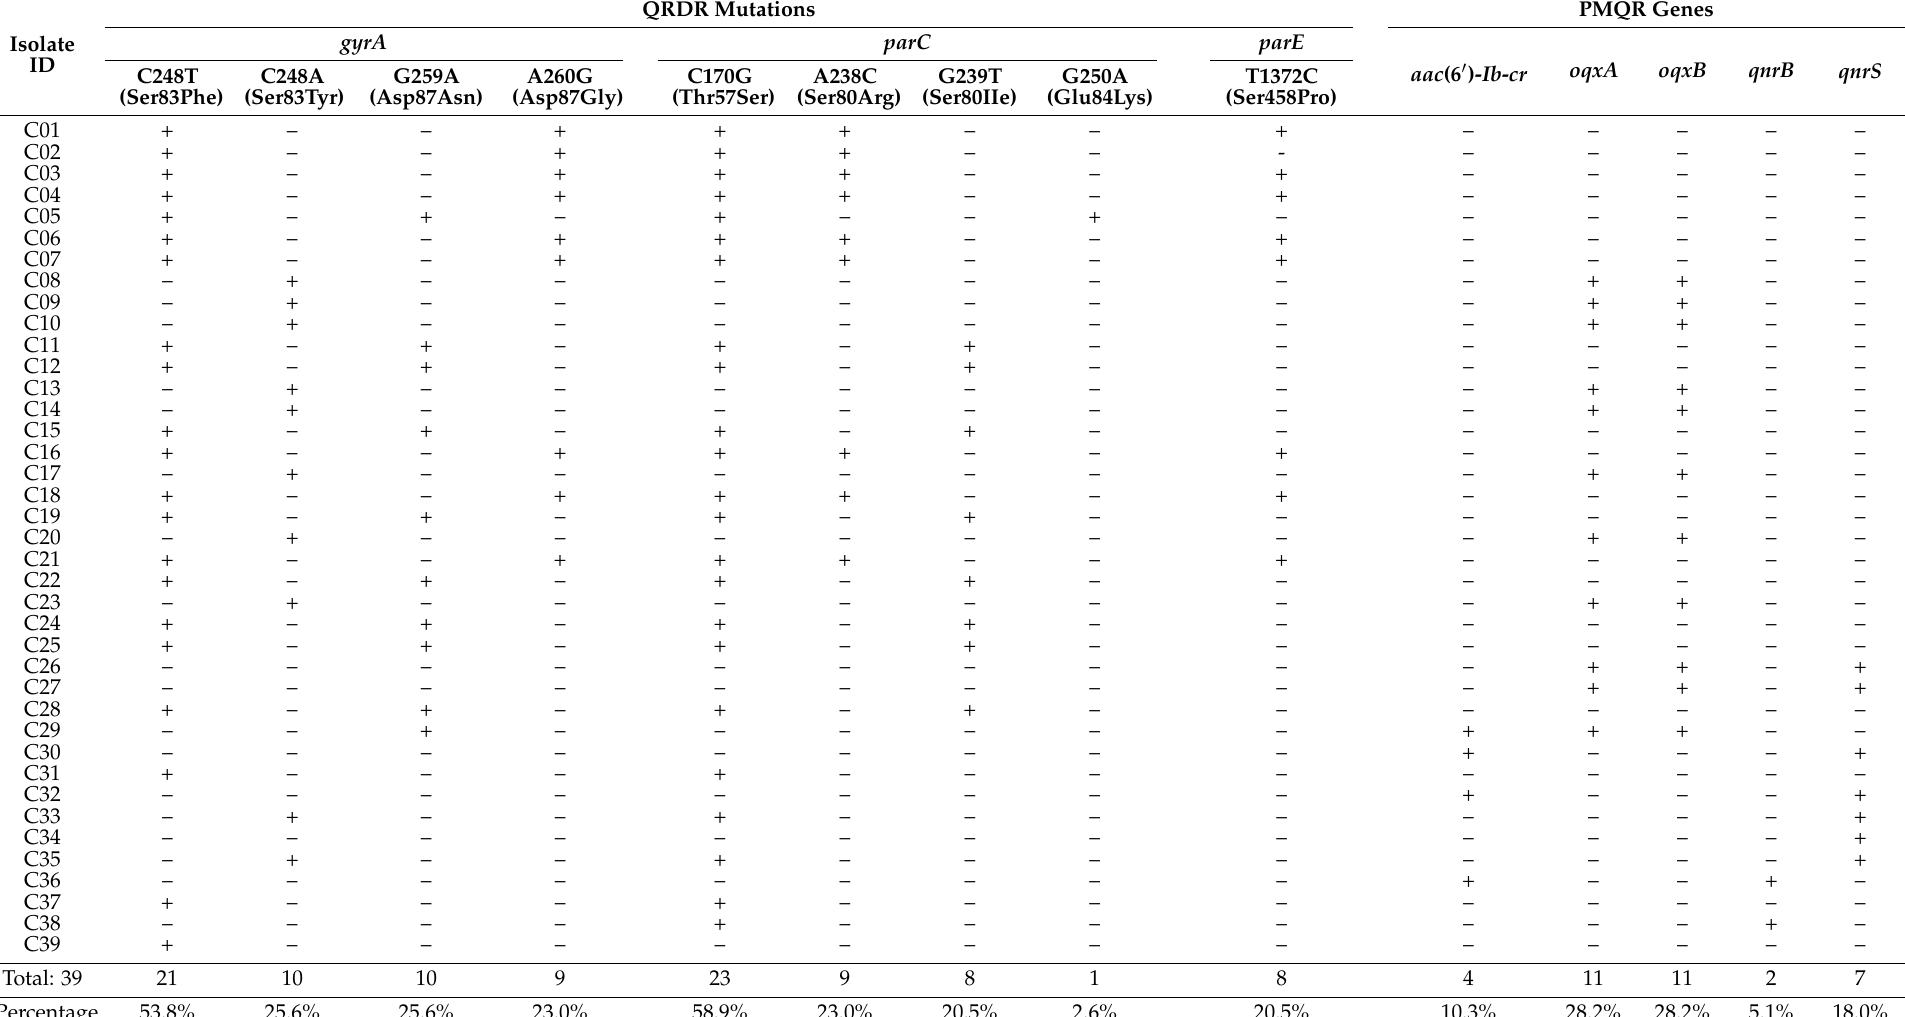
Table 1. Genomic point mutations of the four QRDR genes and presence of PMQR genes in the 39 CIP-nonsusceptible NTS